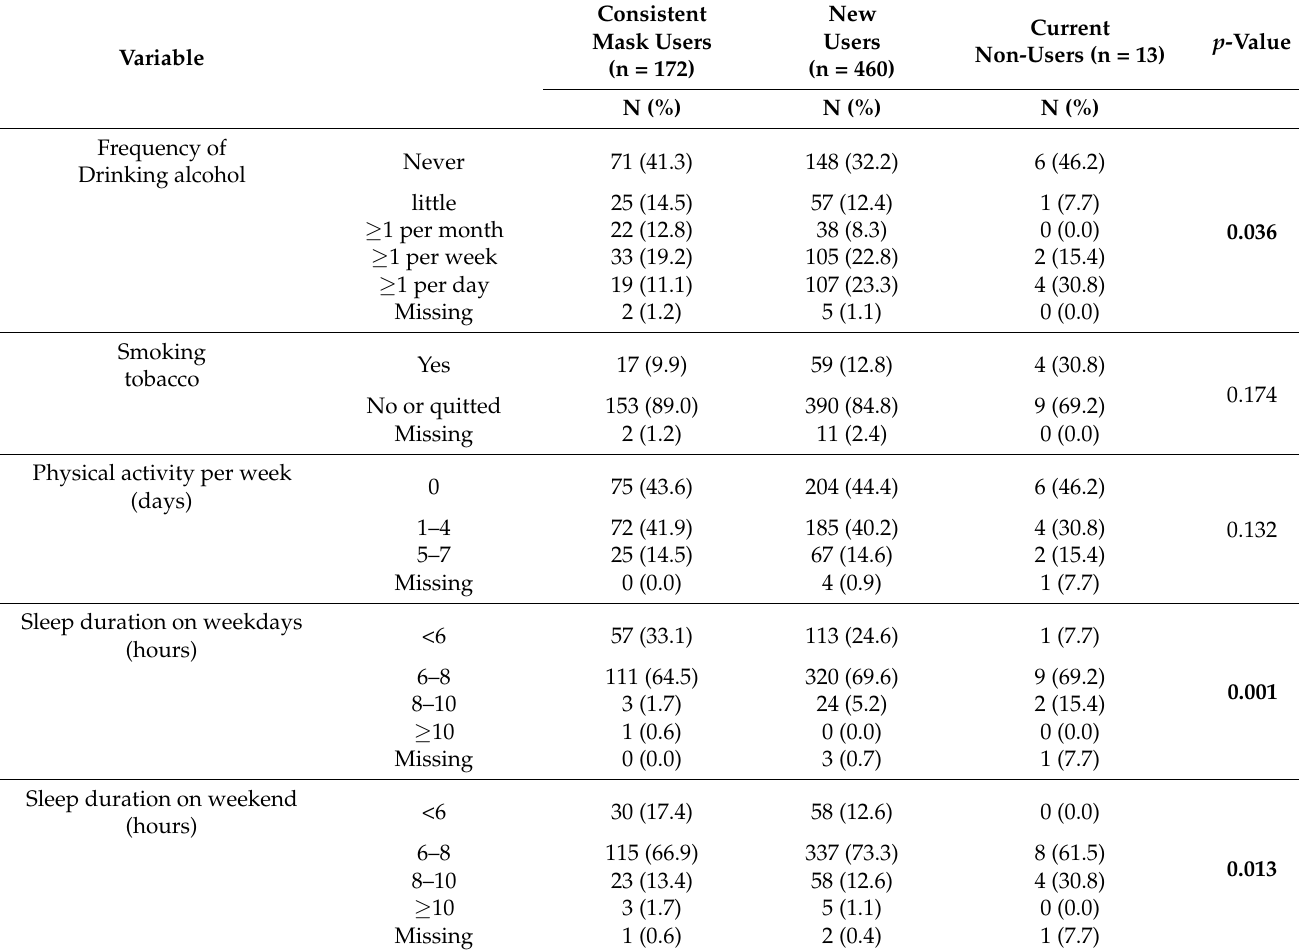
Table 3. Distribution of lifestyle behaviors before the pandemic by mask use behavior (n = 645).